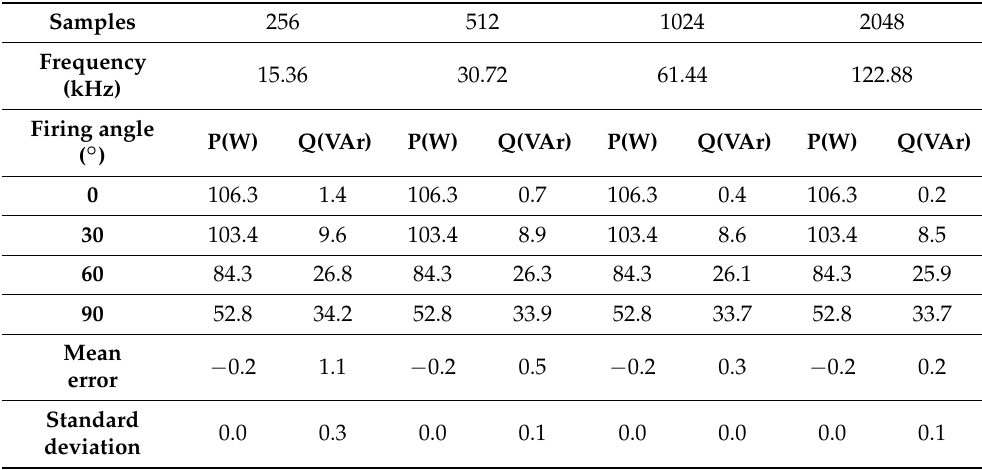
Table 16. Powers evaluated by CPT for the non-linear load considering 256, 512, 1024, and 2048 samples.